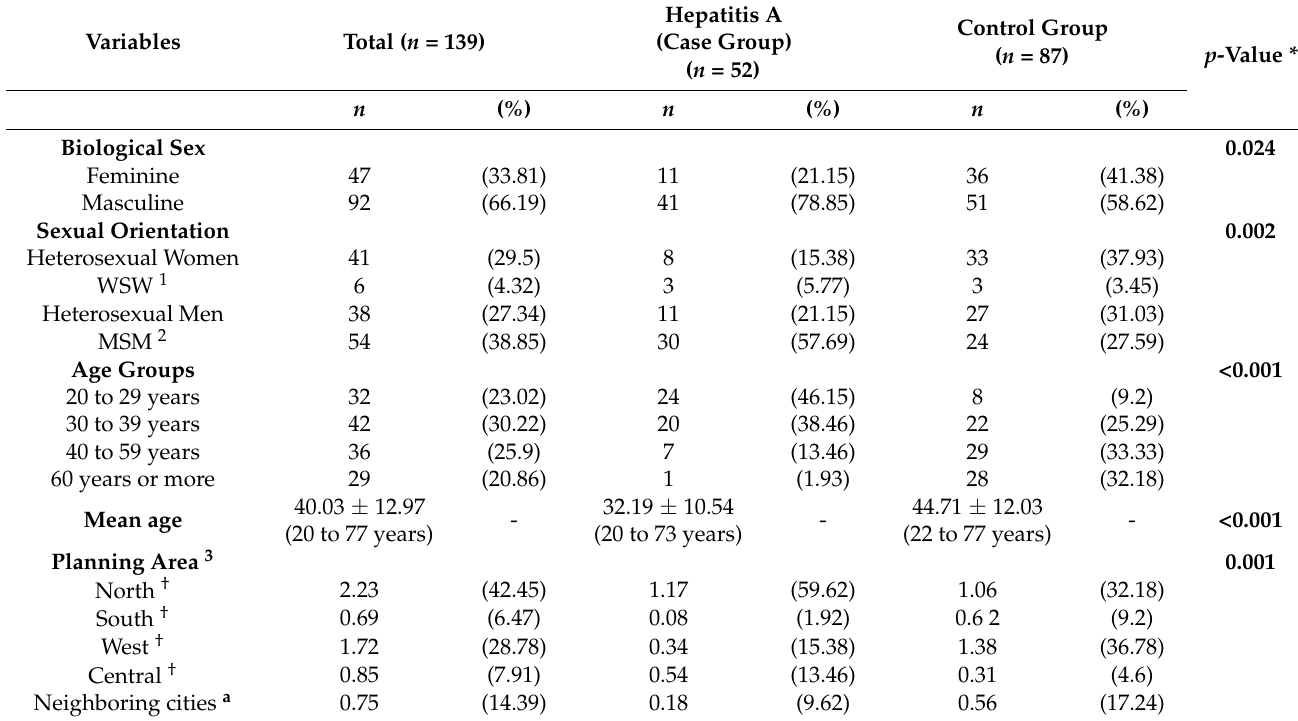
Table 1. Descriptive sociodemographic characteristics (2017–2019).